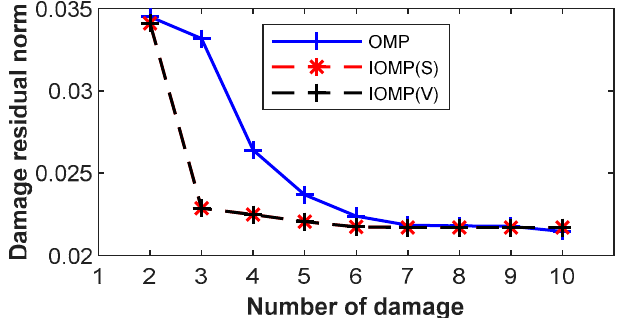
Figure 8. Contrast with sparsity in simply supported beam simulation.